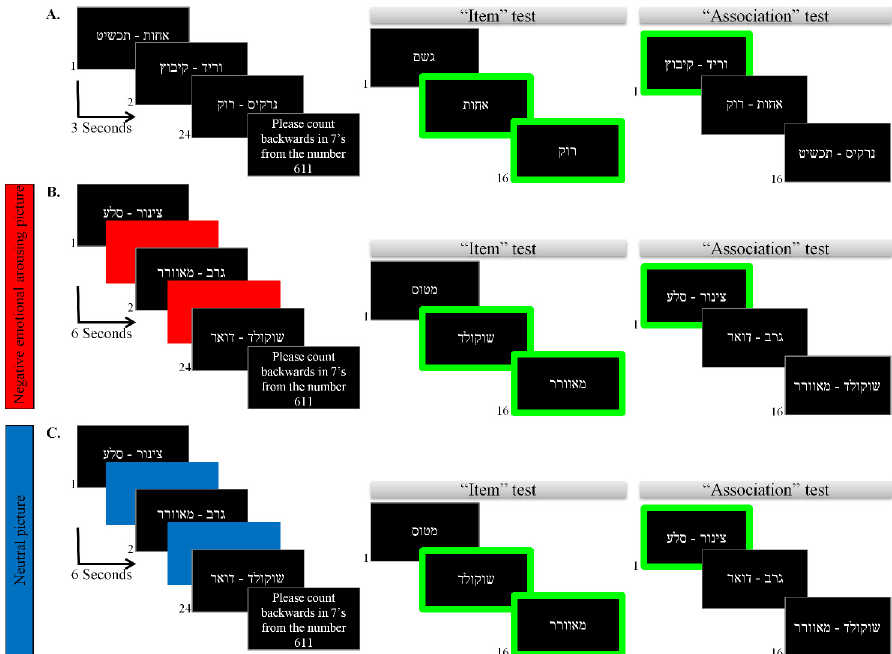
Fig 1. Experimental paradigm. Participants were presented with a study list of 24 unrelated (visually or semantically) emotionally neutral pairs of words, one at a time. The first two lists (A) were used as baseline while the two remaining lists were learned under negative emotional arousal (B) / neutral (C) condition. Participants were instructed to respond to each stimulus on the keyboard with a designated “ yes ” key (= 1) for targets and a “ no ” key (= 0) for